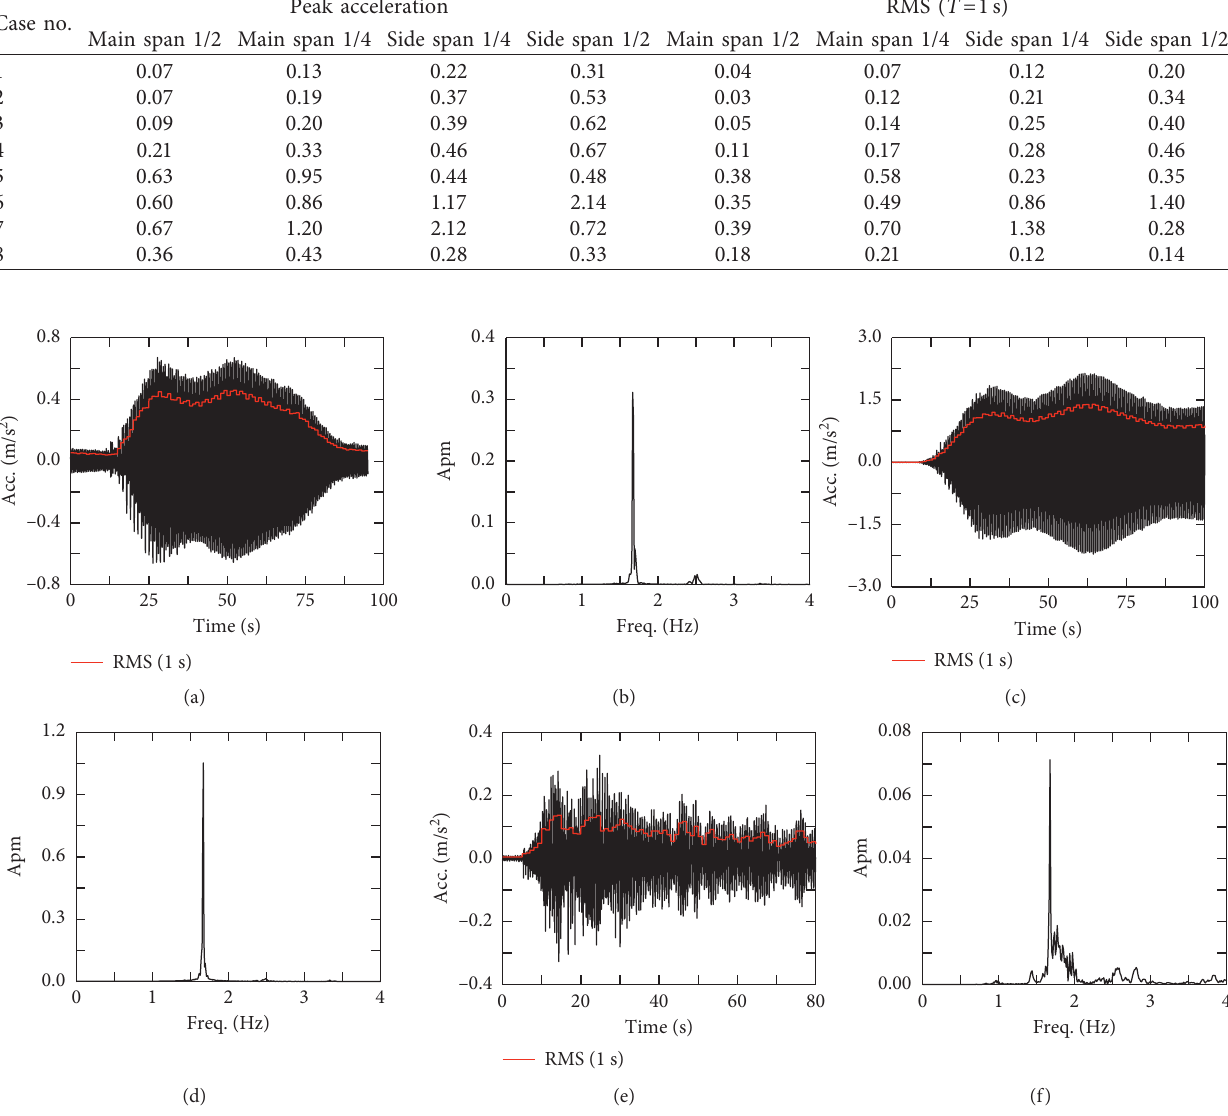
Table 7: Peak acceleration and maximum 1s-RMS (m/s 2 ).